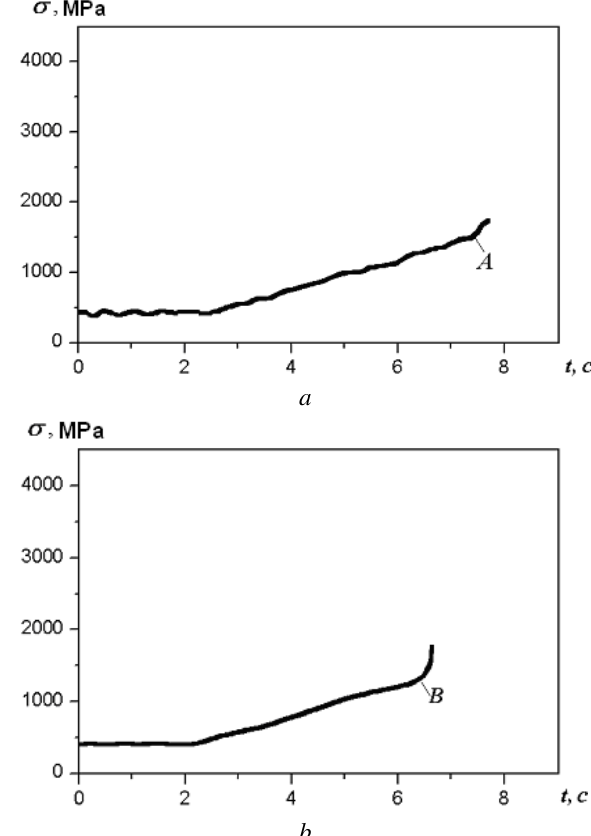
Fig 5. Contact pressure regularities that change with time, re- ceived by processing of signals from the strain gauge transducer (a) and the average amplitude of the AE resulting signal (b) : A, B – the moments of seizure defined, accordingly, using the sig- nal from strain gauge transducer and the AE